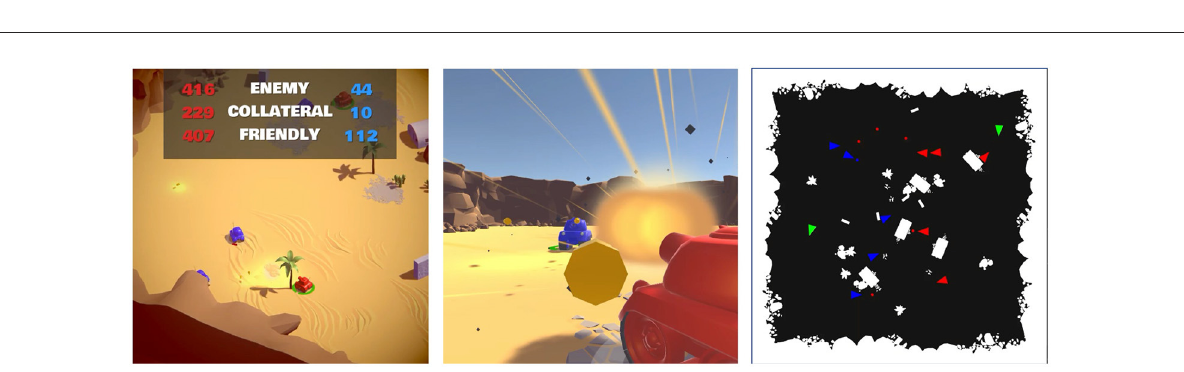
FIGURE3 TanksWorld Multi-Agent Environment for AI Safety Research. These images illustrate different views of the Tanksworld environment (Left) is a birds-eye rendering of the environment, (Center) is an agent’s-view rendering, and (Right) is the state representation actually provided as observations to the RL